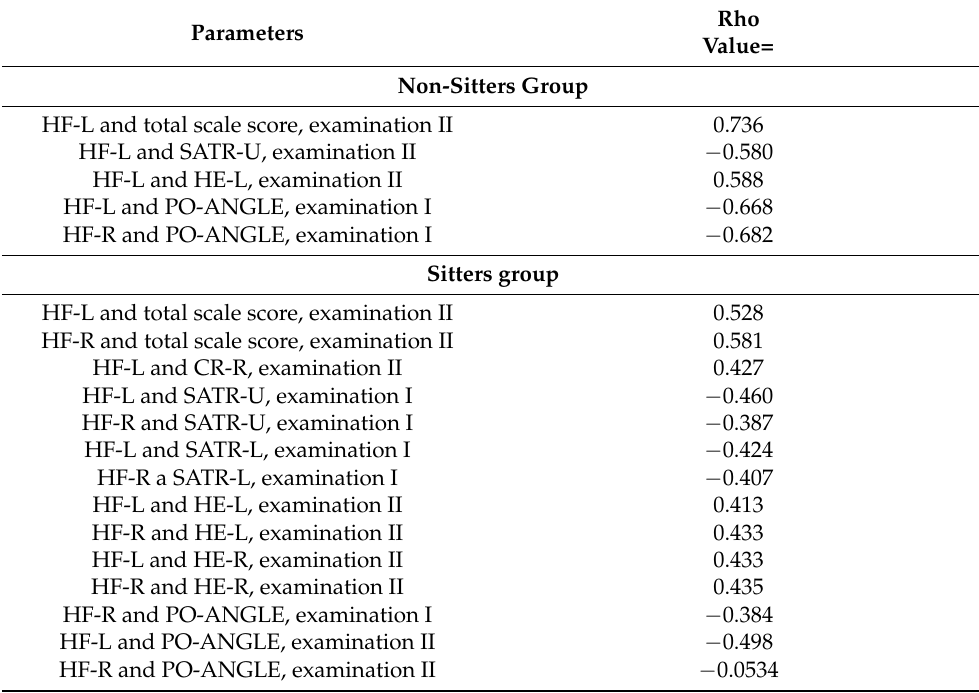
Table 5. The relationship (Spearman’s test correlation) between the measured parameters and the magnitude of the difference of the CHOP and HFMSE scale